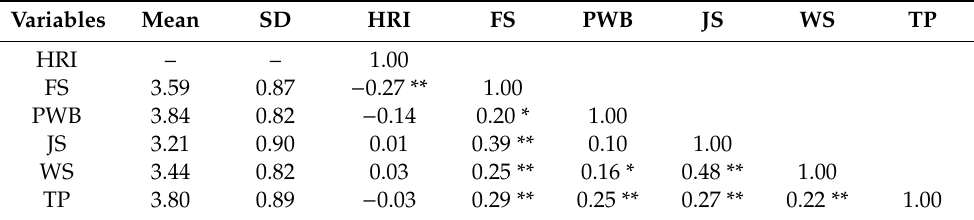
Table 7. Descriptive statistics and correlation matrix for older workers.